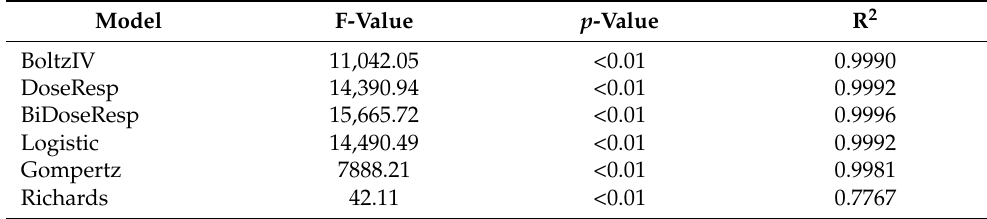
Table 2. Adjustment of the accumulated number of documents to sigmoid growth models.